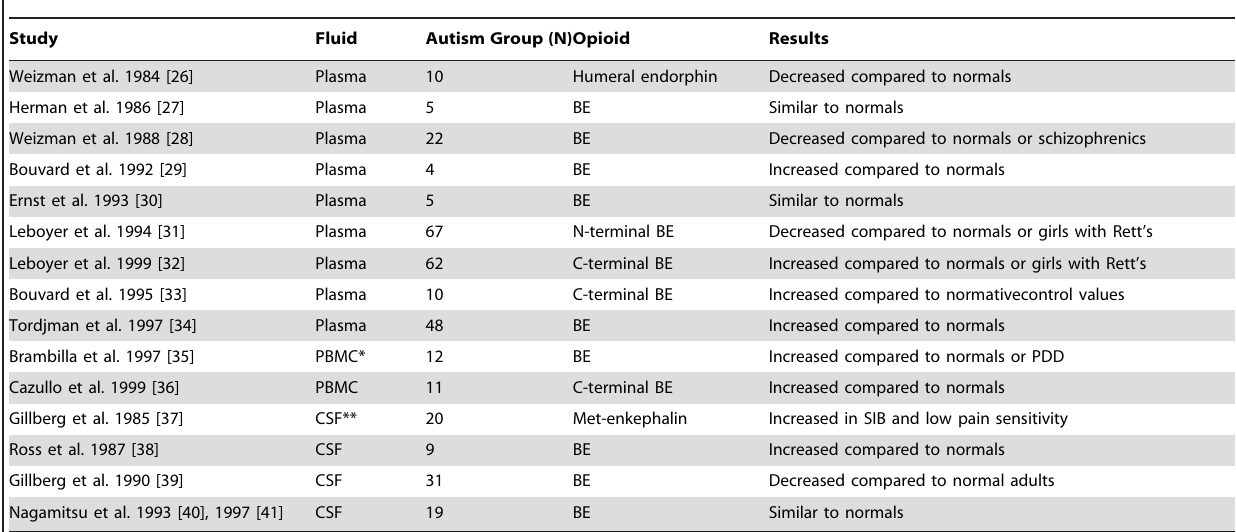
Table 1. Studies of Endorphin and Enkephalin Levels in Individuals with